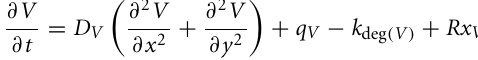
FIGURE 1 | Schematics. (A,B) Schematics of the 2-D computational model space. In (A) , sFlt-1 is secreted from an opposing wall of parenchymal cells. In (B) , sFlt-1 is secreted from a layer of parenchymal cells below the interstitial space. Diffusion in the z direction is assumed to be instantaneous, and both